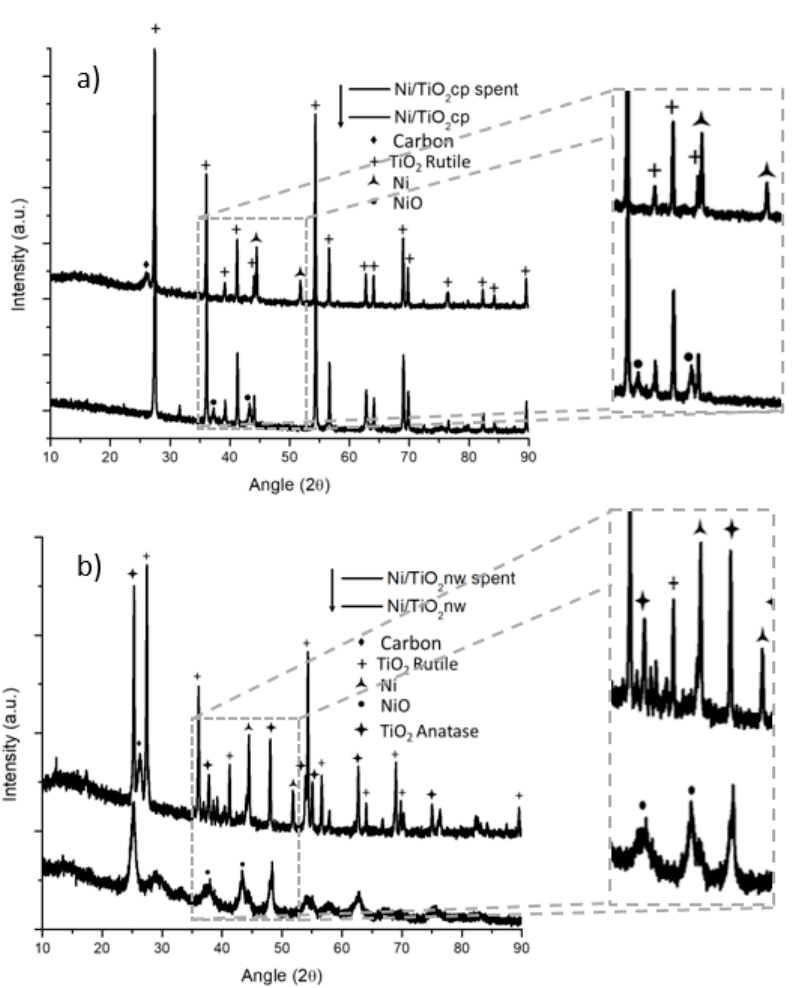
Figure 3. XRD of nickel-decorated titania prepared and tested in the dry methane reforming process; ( a ) commercial particle support and ( b ) nanowire support.